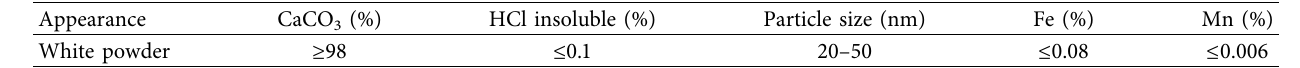
Table 3: Chemical and physical properties of nano-calcium carbonate.